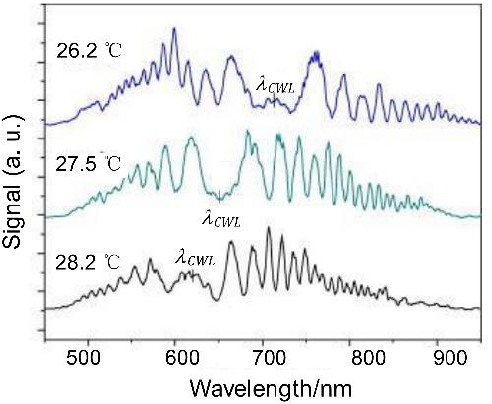
Figure 11. Shift in the CWL in MZI employing the liquid-core fiber shown on measured spectra for temperatures of 28.2, 27.5, and 26.2 ◦ C. Reprinted with permission from Ref. [40]. Copyright 2011 Elsevier.